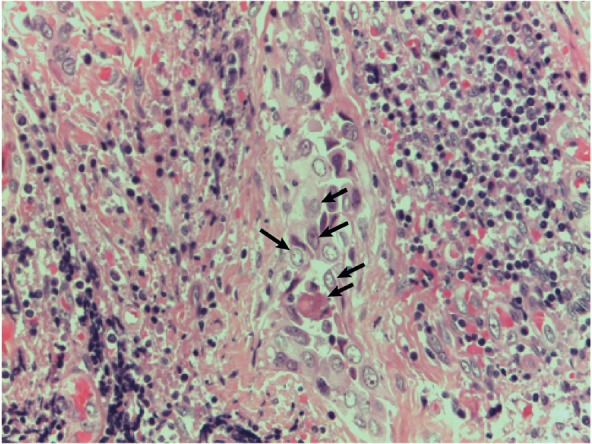
Papillary carcinoma sclerosing variant with the squamous metaplasia area clearly evident by p40 staining and indicated by arrows. x400 magnification.